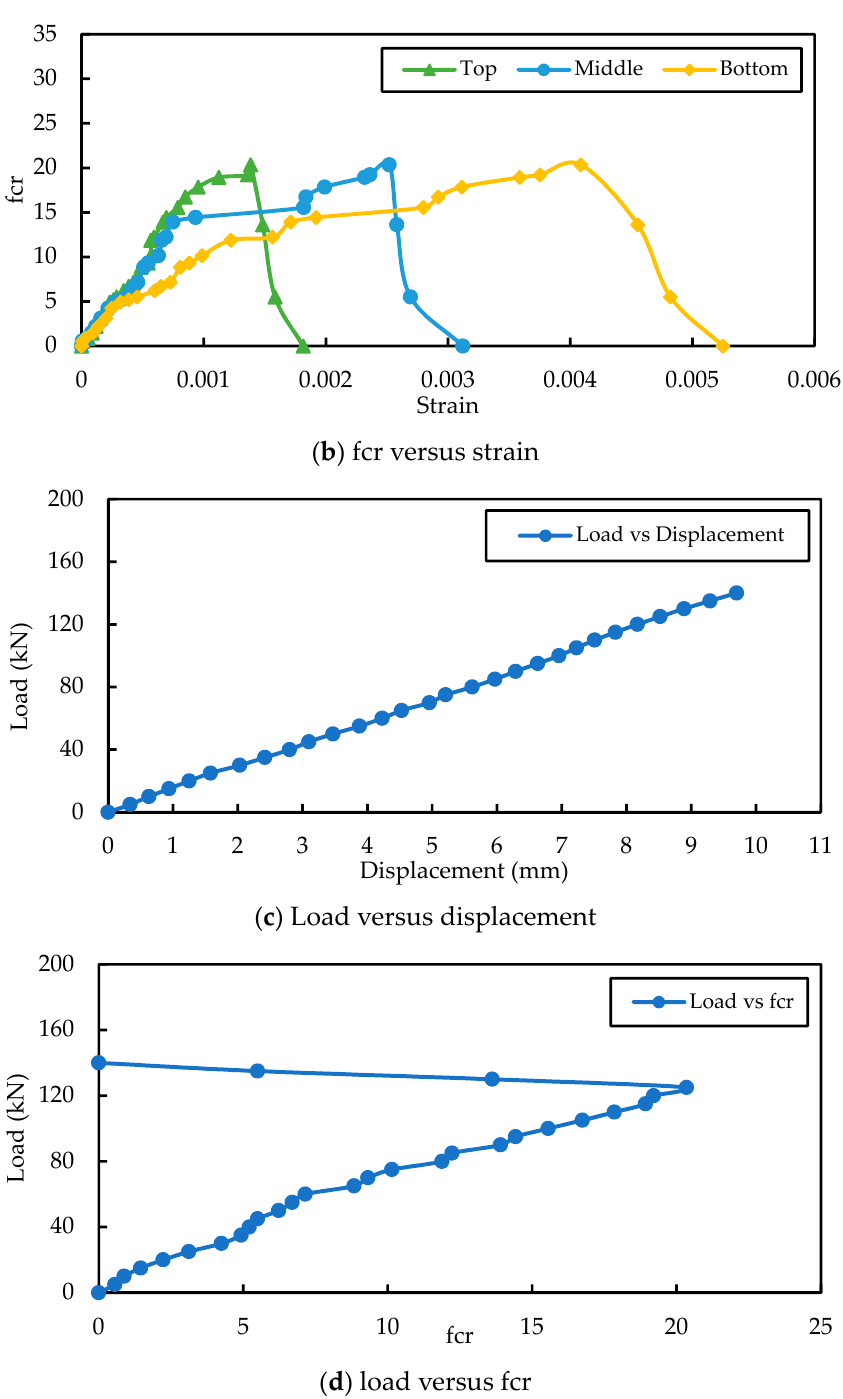
Figure 8. Graphical representation of ( a ) stress vs. strain, ( b ) fcr vs. strain, ( c ) load vs. displacement, and ( d ) load versus fcr behaviour of the brass fibre added fresh mortar layer cast on an existing concrete beam of length 1.5 m.